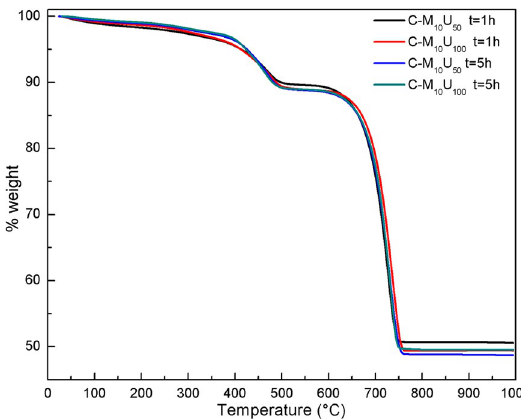
Figure 3. TGA thermogram for samples C-M10 after sonofragmentation.